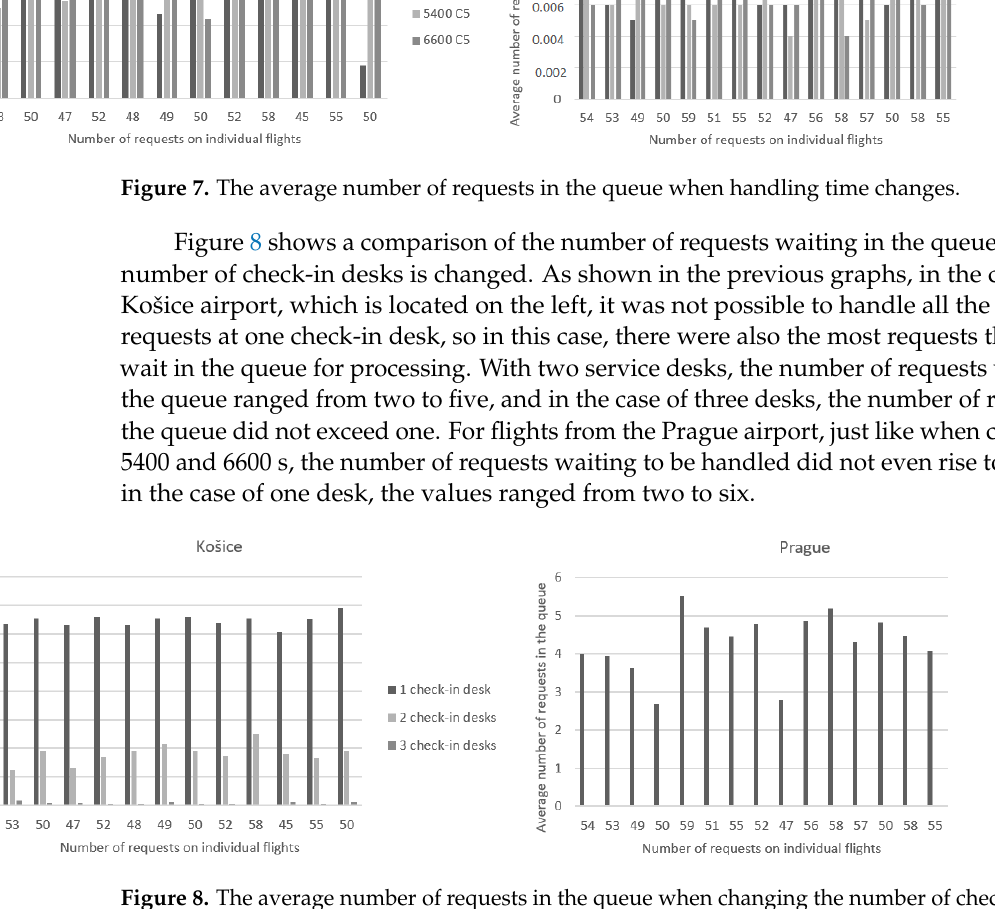
Figure 8. The average number of requests in the queue when changing the number of check ‐ in